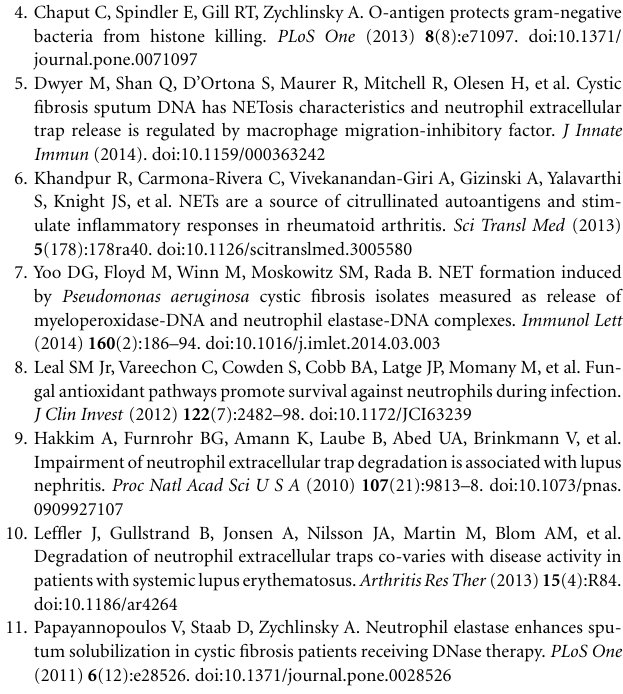
concentrations of the anti-microbial NET-associated proteins trigger P. aeruginosa adaptation and stimulate acquisition of mutations that are associated with polysaccharide production and antibiotic resistance. Consequently, P. aeruginosa acquires mucoid phenotype (green bacteria embedded in light green polysaccharide).The mucoid P. aeruginosa strains trigger less NETosis due to decreased expression of virulence factors, and may escape from NET trapping by elevated outer membrane vesicle production and DNA